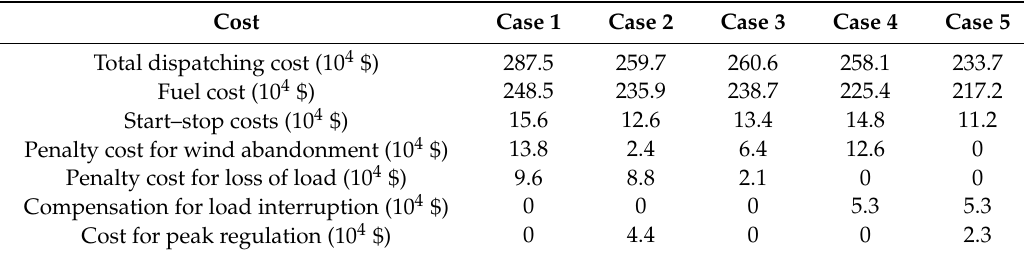
Table 2. Indicators under di ff erent